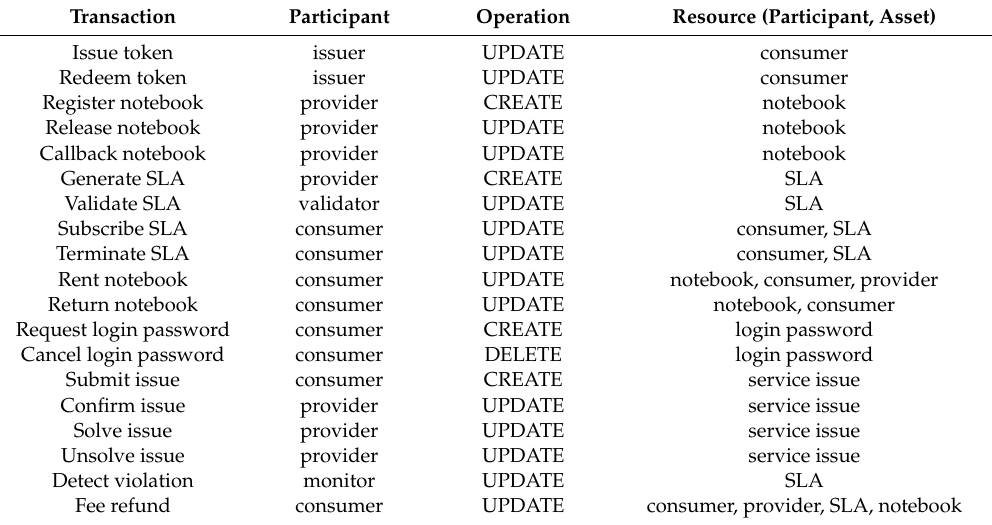
Table 3. Transaction definition in the smart contract.